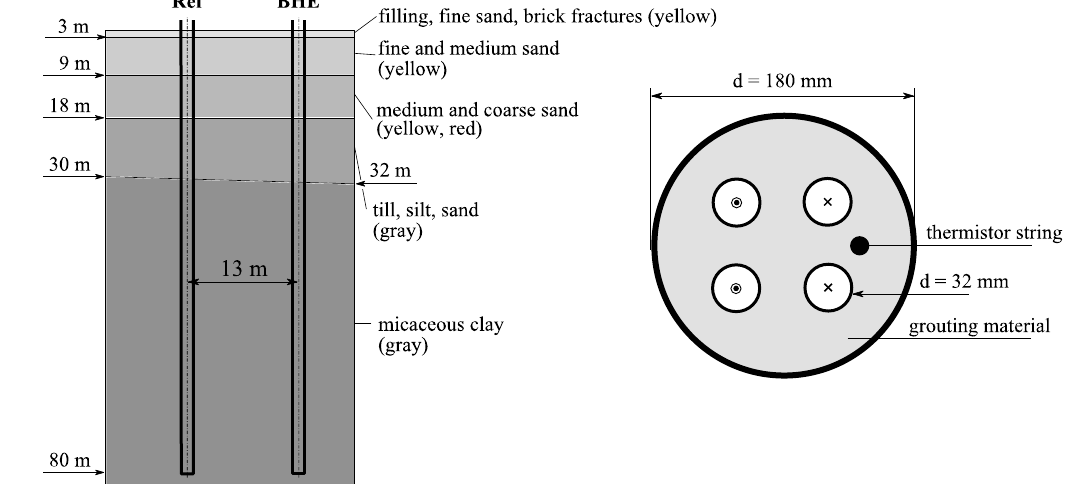
Figure 3. Structure of the soil and design of the borehole heat exchangers.